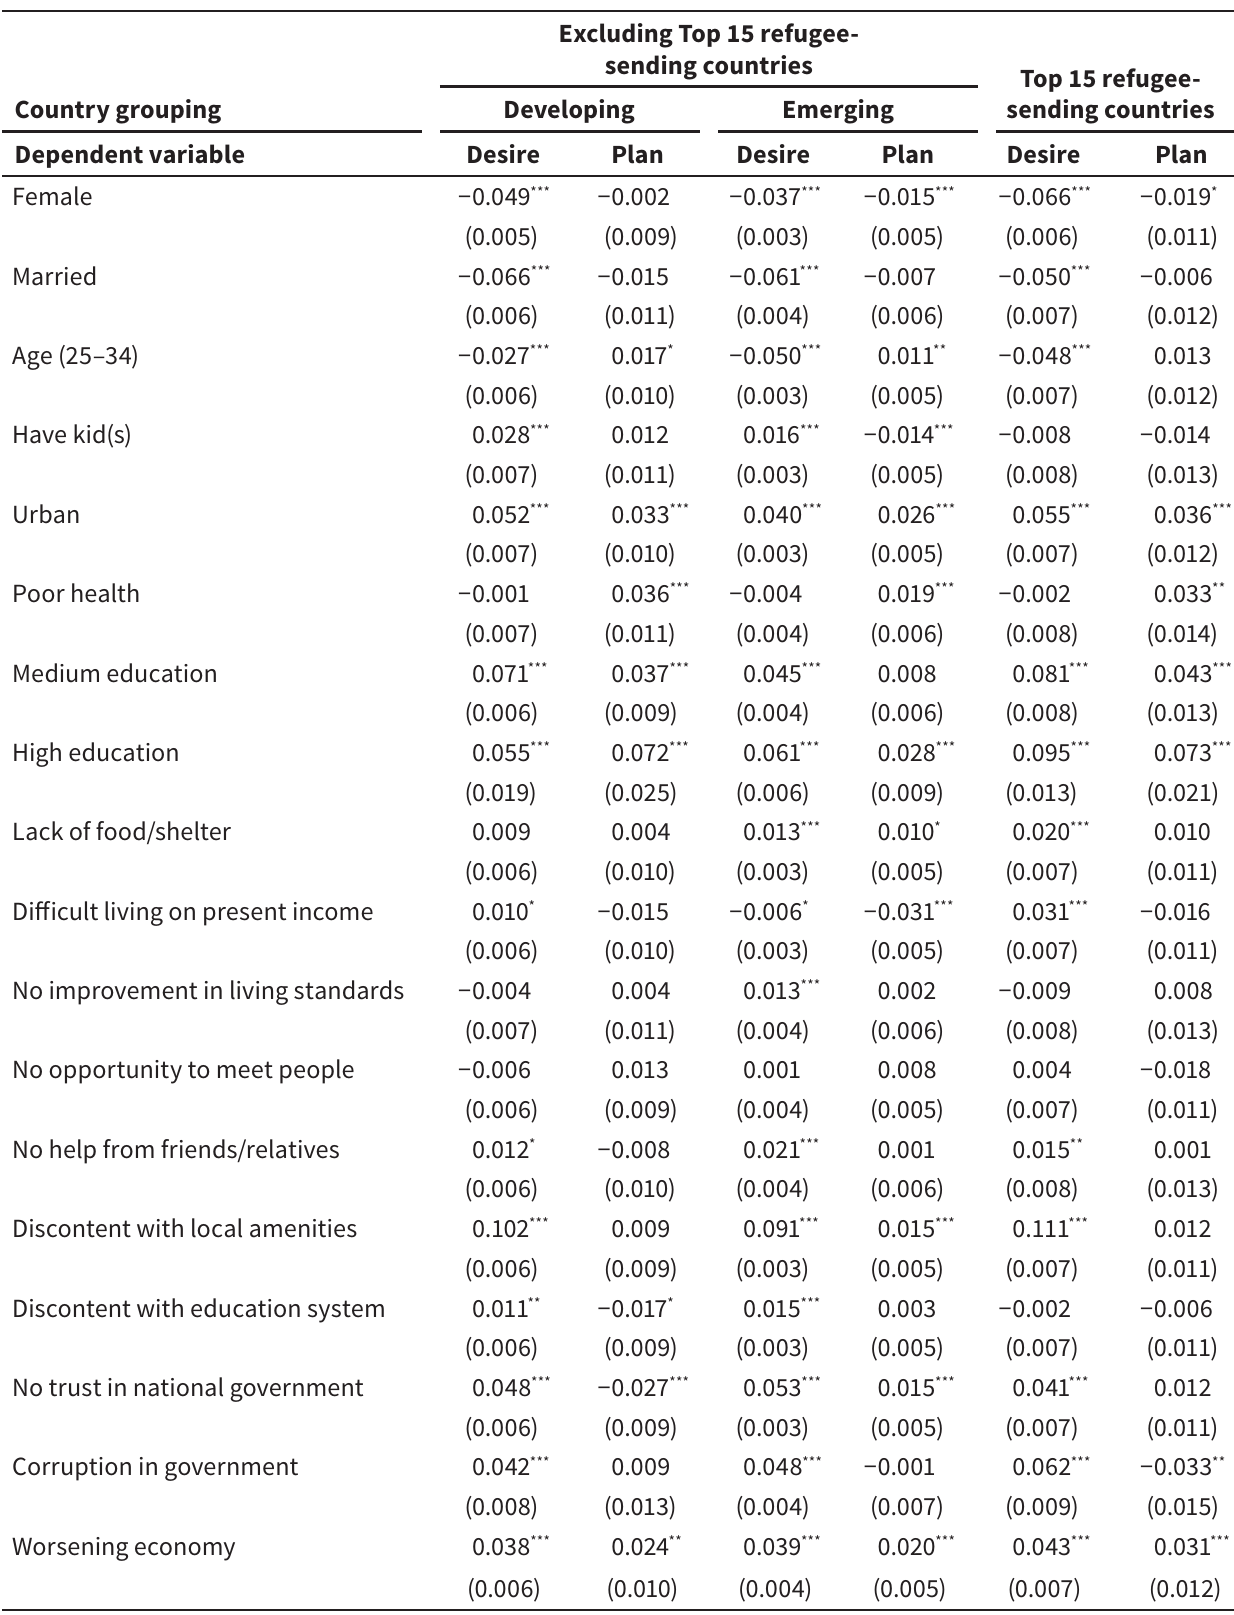
Youth (15–34) desire/plan to migrate abroad in country samples including and excluding Top 15 refu- gee-sending countries, full results corresponding to Panel C of Table